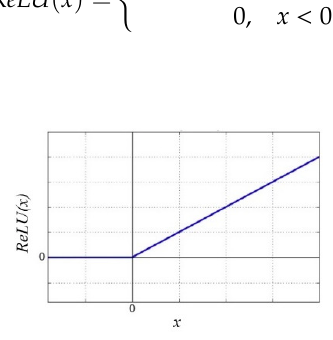
Figure 5. Rectified linear unit (ReLU) activation function.